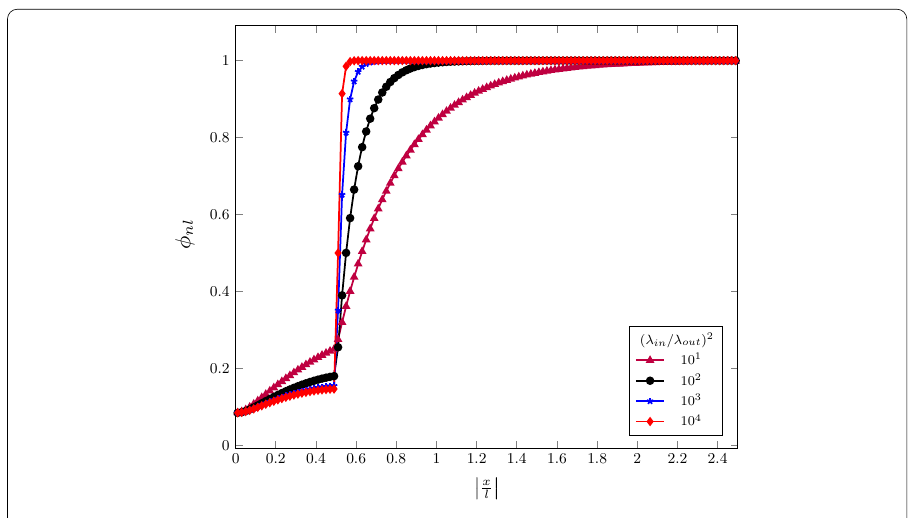
Fig. 3 Nonlocal damage profiles for various length scale ( λ in /λ out ) 2 contrast at an instant when global stress σ has dropped to 0 . 007 σ c